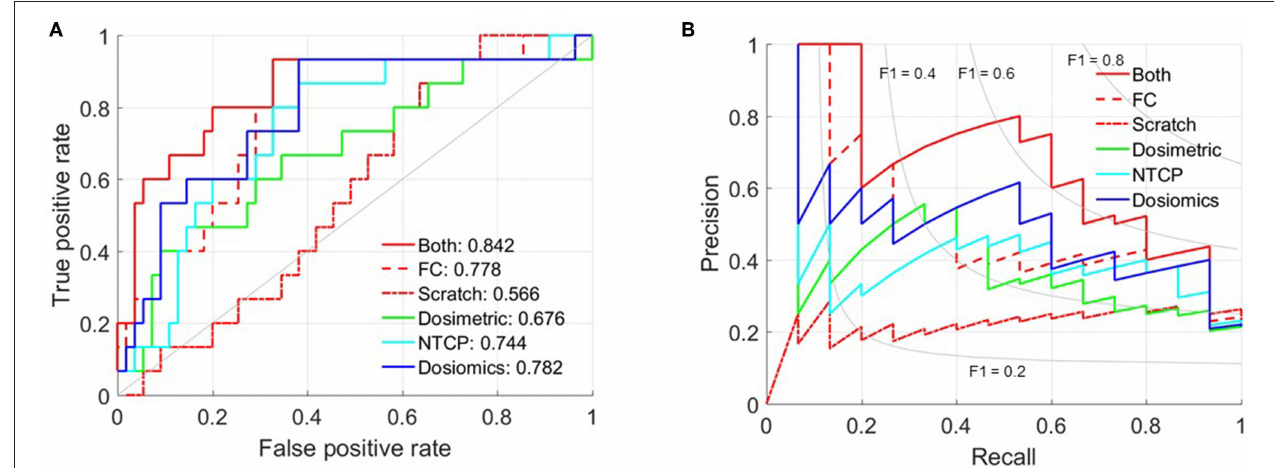
FIGURE 2 | Prediction ability evaluation. (A) ROC curve. (B) Precision-Recall curve.